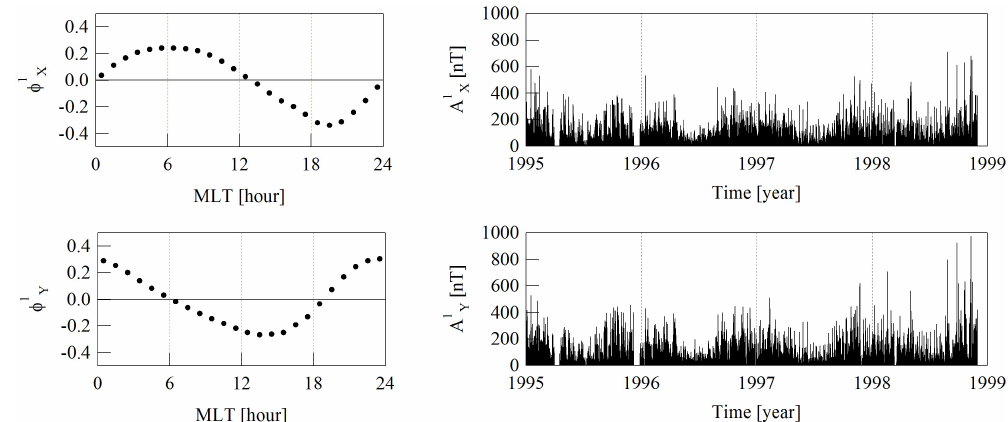
Fig. 2. On the left, the first EOF associated to the X (top) and Y (bottom) components, respectively; on the right, their associated